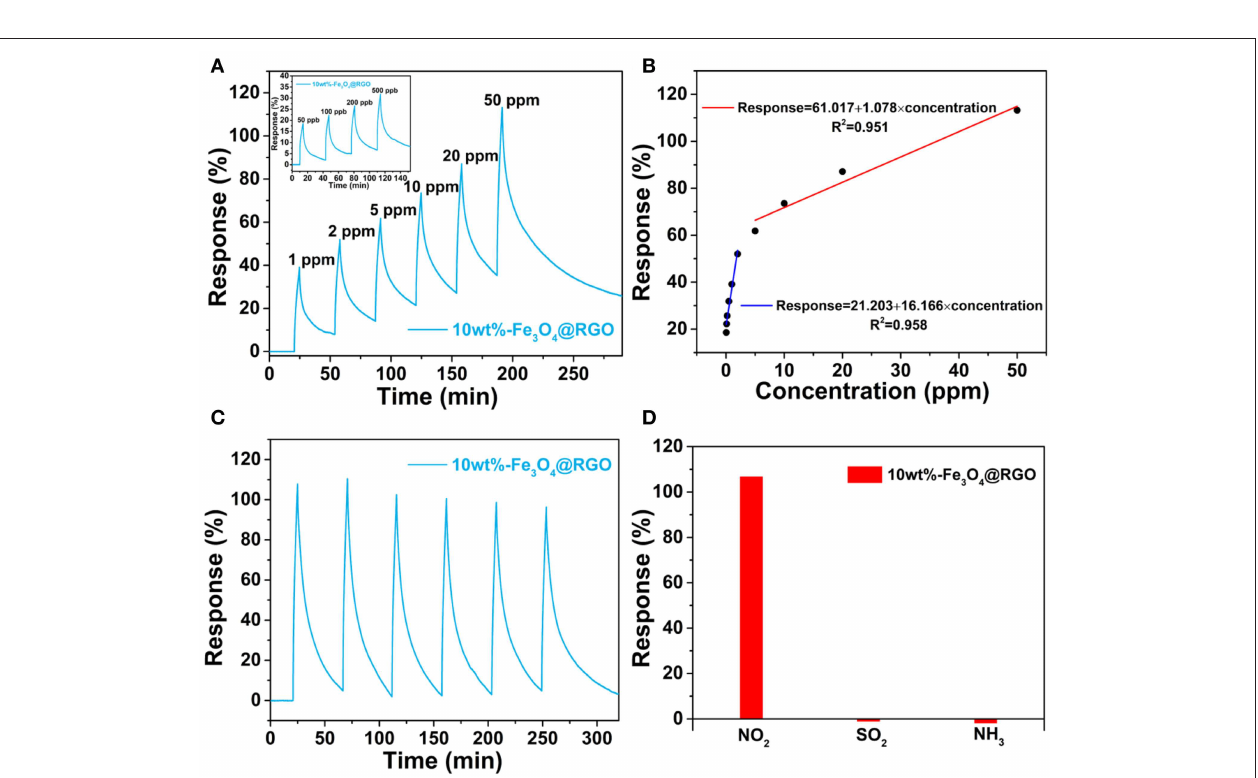
FIGURE 6 | (A) Response curves and (B) comparison of response values of RGO and the different material mass ratio of the Fe 3 O 4 @RGO toward 50 ppm NO 2 .